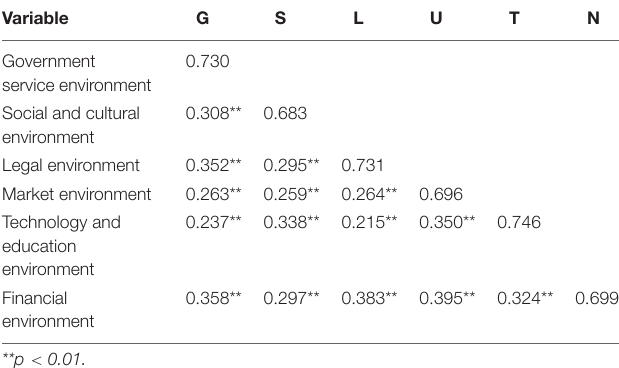
TABLE 6 | Correlation analysis of regional soft environment.